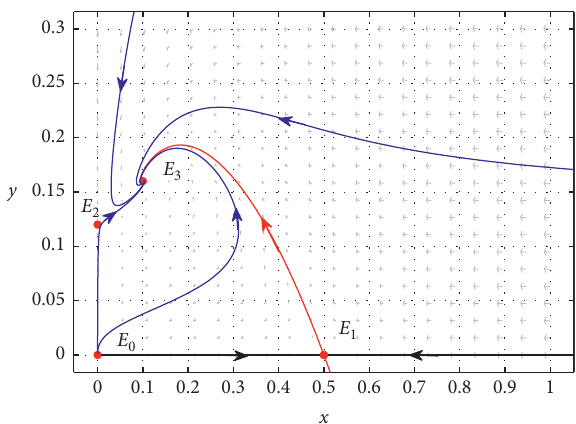
Figure 5: Phase portrait for system (12) with α � ρ � 1 , β � 0 . 5, m � 0 . 3, c � 0 . 5, and δ � 0 .